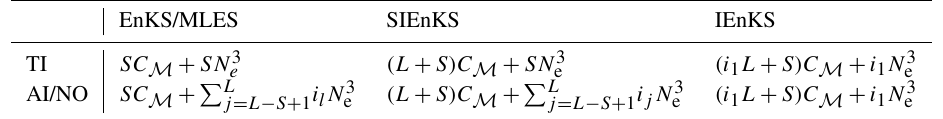
Table 1. Order of the SDA cycle flops for lag= L , shift= S , tuned inflation (TI), or adaptive inflation (AI)/nonlinear observation operator (NO). EnKS/MLES